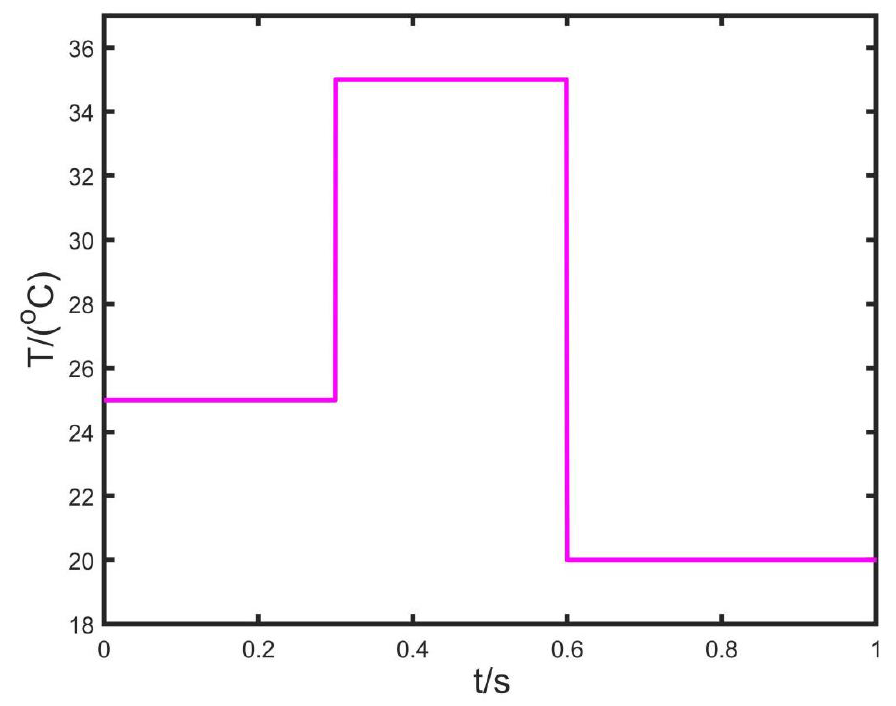
Figure 9. Temperature change curve of PV array.